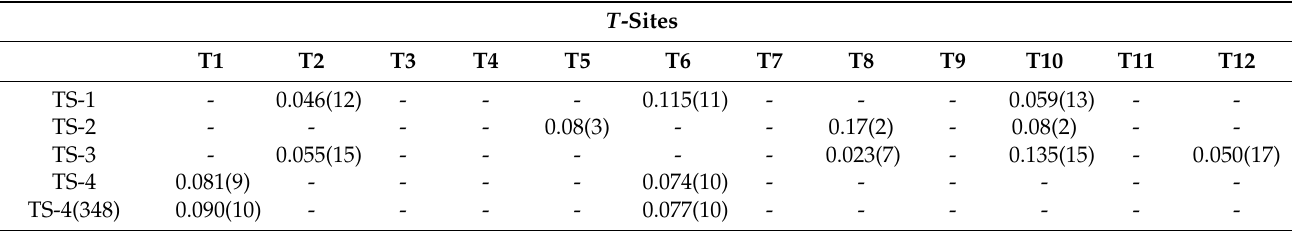
Table 13. Occupation of tetrahedral sites by Ti 4+ ions. T